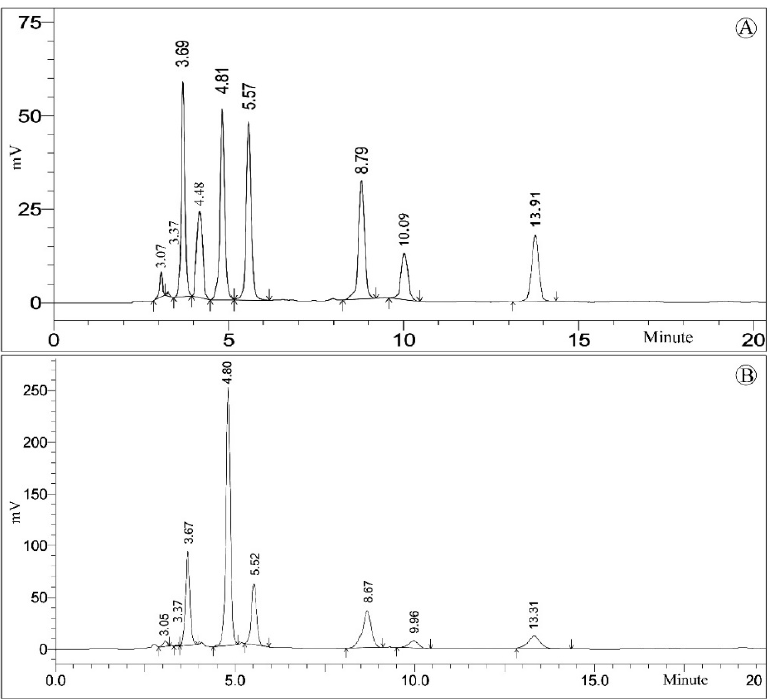
HPLC-PDA chromatograms of organic acid standards ( A ) and wood apple Figure 4. HPLC ‐ PDA chromatograms of organic acid standards ( A ) and wood apple ( Limonia acidis ‐ ( Limonia acidissima L.) fruit pulp ( B sima L.) fruit pulp ( B ).